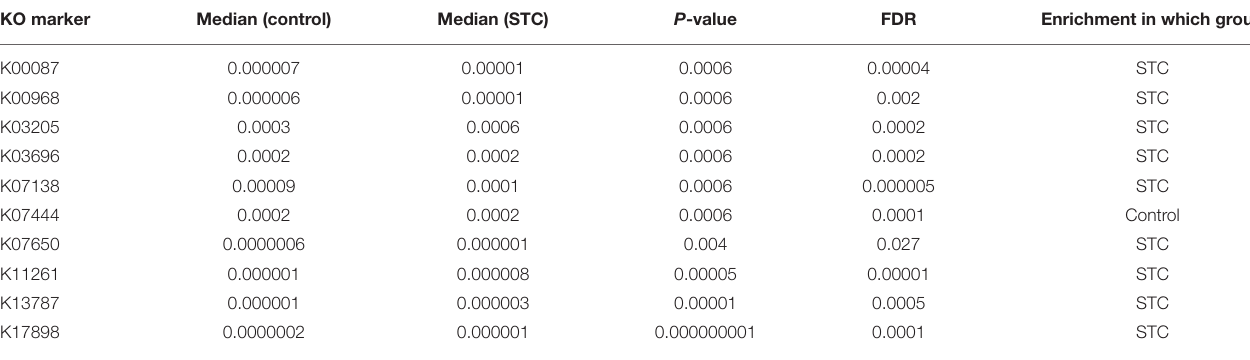
TABLE 2 | The best 10 KEGG Ontology (KO) markers in the receiver operating characteristic (ROC) curve picked from the 859 differential KO markers. KO marker Median (control) Median (STC) P -value